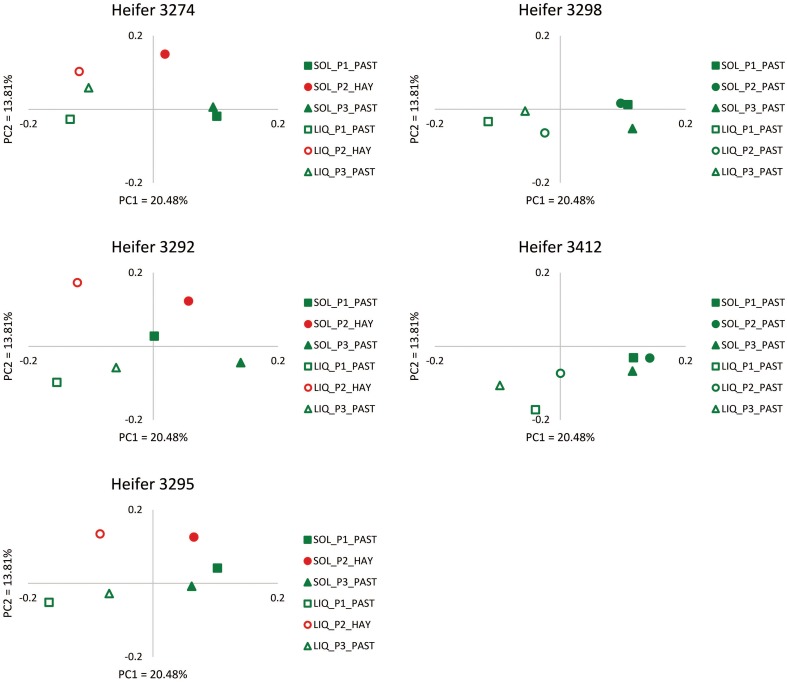
Scatter plots of PC1 (x-axis) vs. PC2 (y-axis) from weighted UniFrac principal component analysis (PCoA) of the bacterial communities as determined by 454 pyrosequencing for each of the five heifers. The amounts of variation explained by PC1 and PC2 are 20.48 and 13.81% respectively. Subsampling was performed to normalize among the samples.